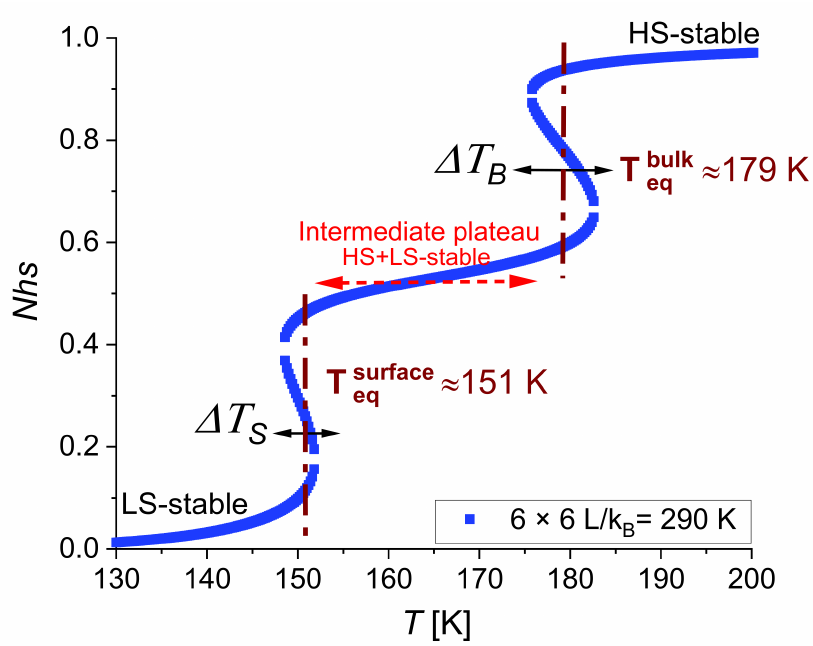
Figure 3. Thermal evolution of the HS fraction in an SCO system with size 6 × 6. The computa- tional parameters are: ∆ / k B = 1300 K, G / k B = 172 K, J bb / k B = 60 K, J ss / k B = 50 K, J bs / k B = 20 K, L / k B = 290 K and ln( g ) = 6.01.